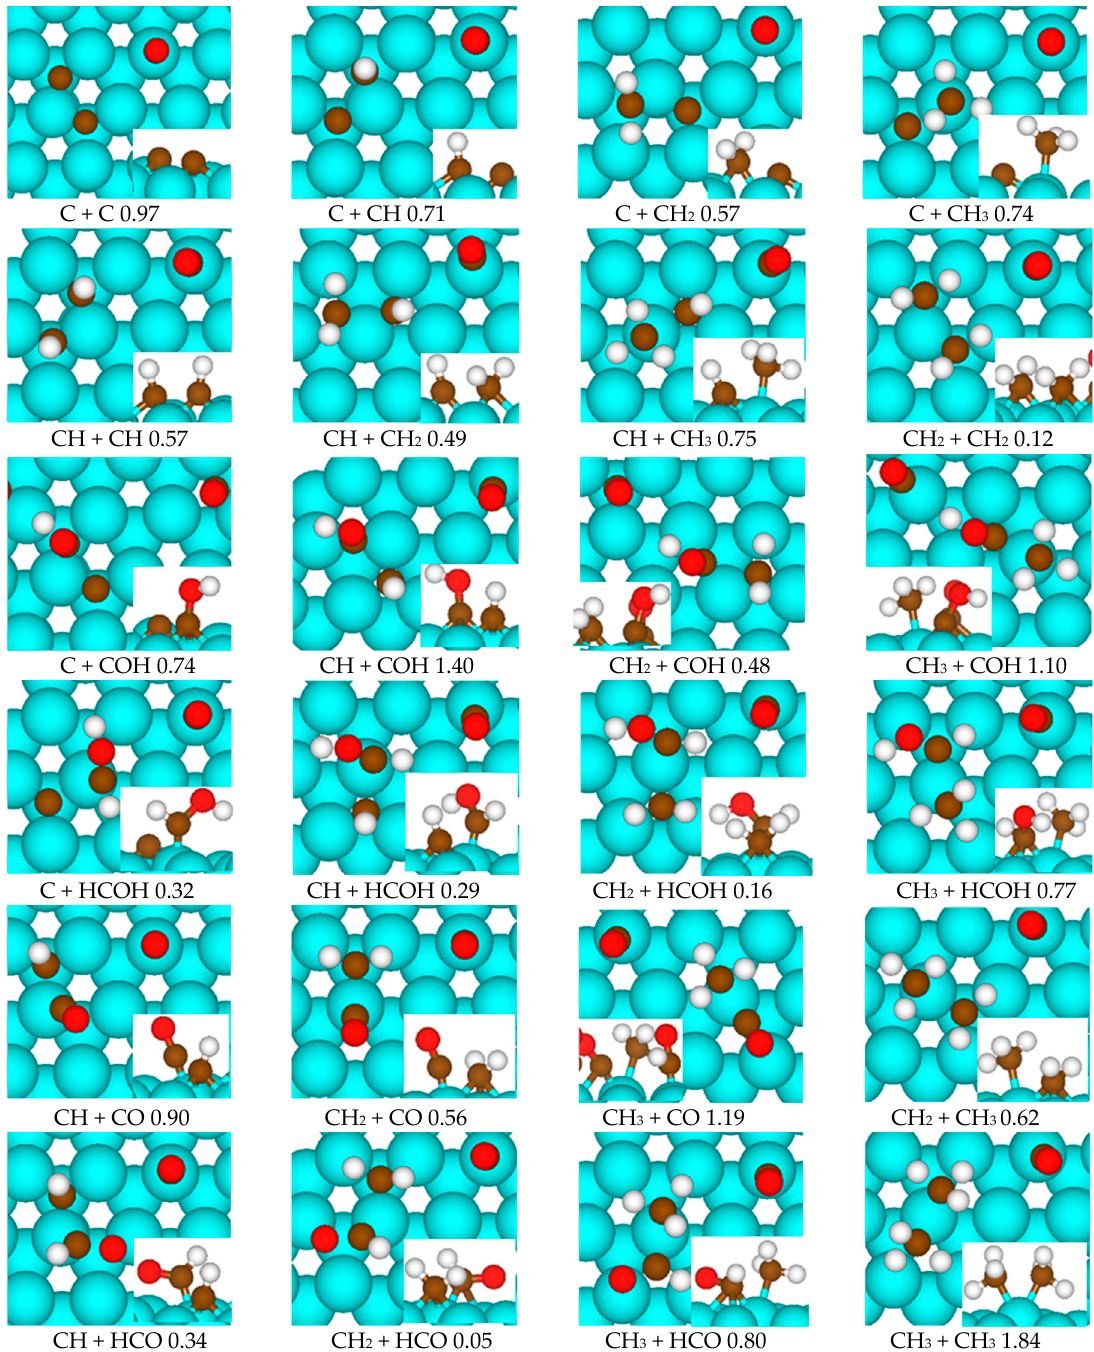
Figure 2. Top views and side views (inserted) of transition states for the C 1 + C 1 coupling reactions. The number represents the activation energy in eV.